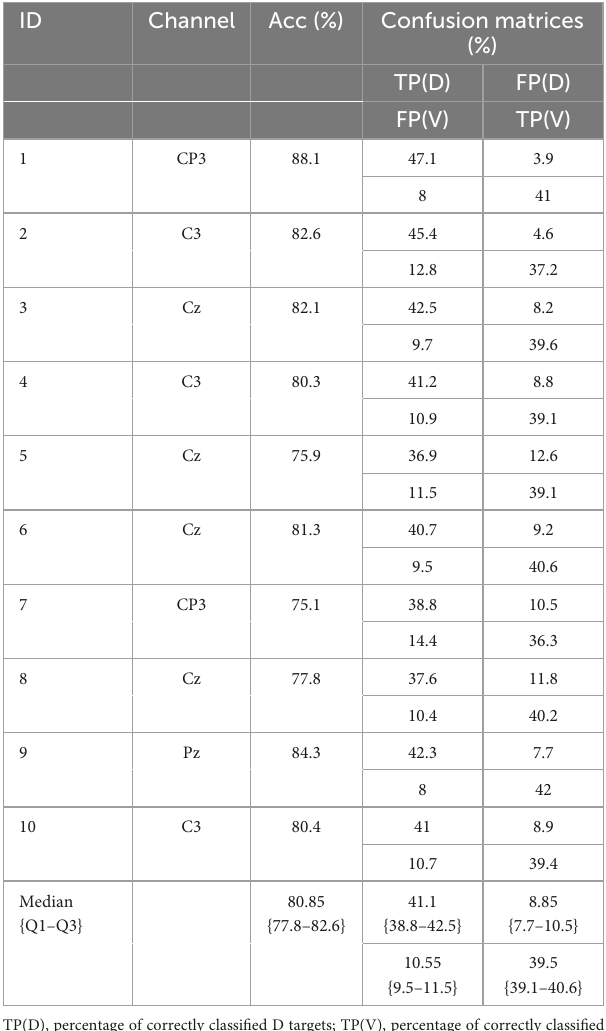
TABLE 3 Best BCI channel-performance per subject (SVM classifier, SEP10 averaging, and feature extraction/selection–FS1) and confusion